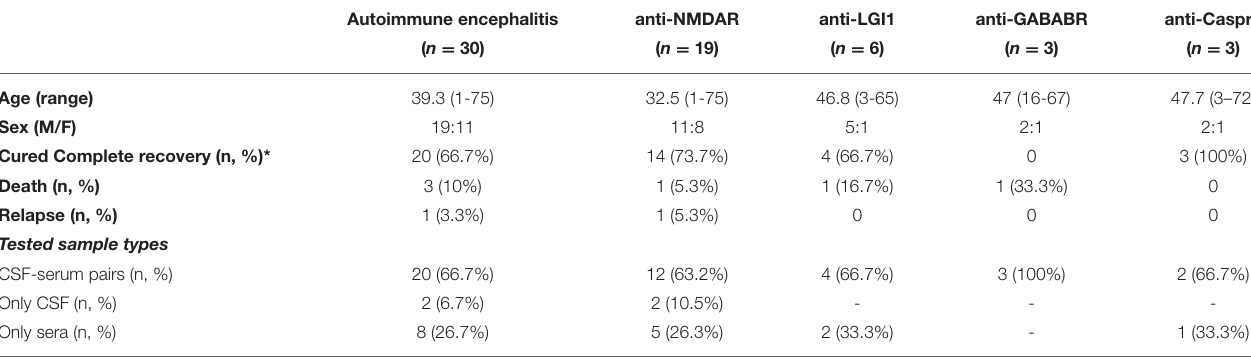
TABLE 1 | Demographic data and tested sample types in AE